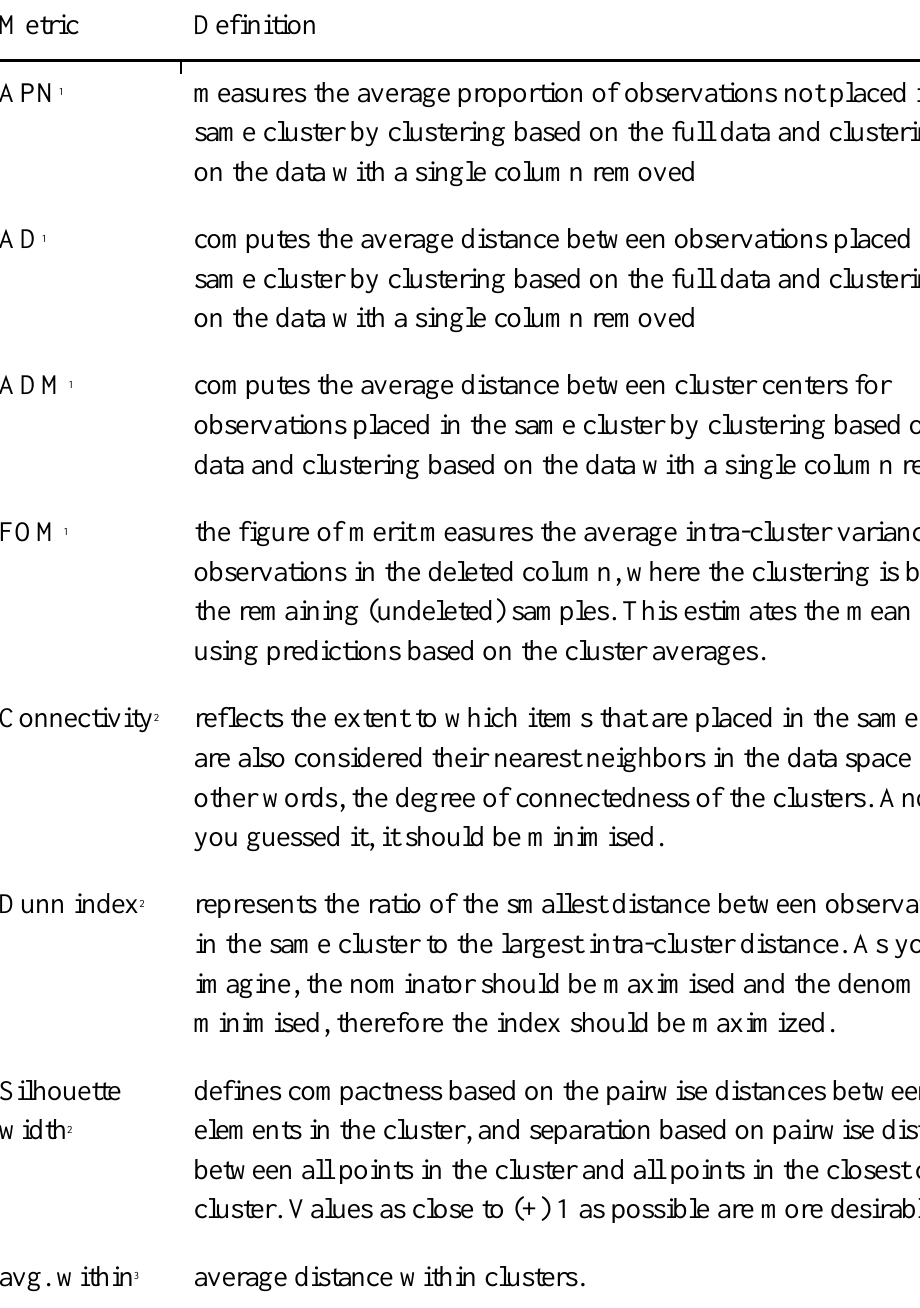
Table A1.3. Cluster validation